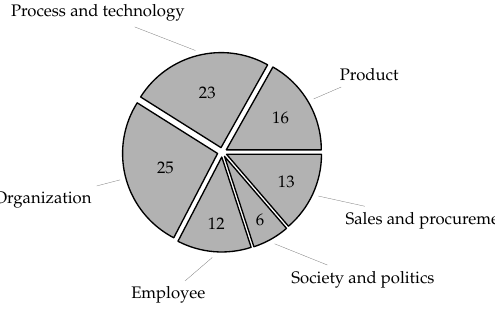
Figure 3. Distribution of literature findings